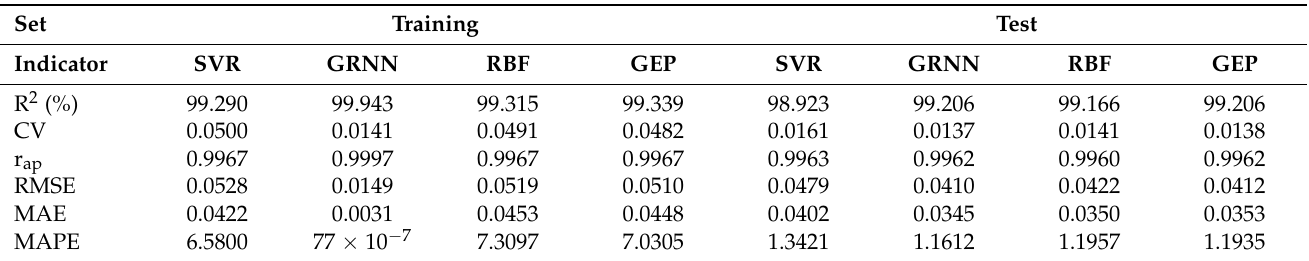
Table 1. The goodness of fit test for the Cu sample mass loss in the cavitation field.